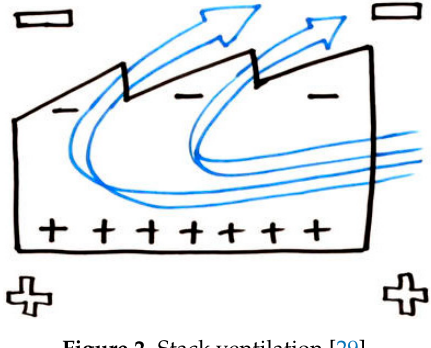
Figure 2. Stack ventilation [29].